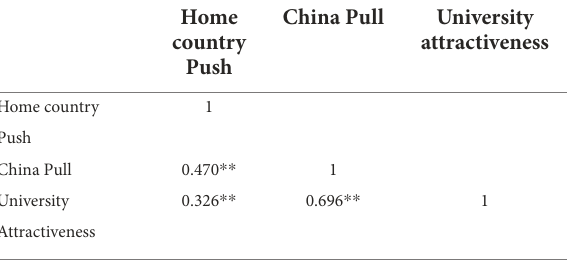
TABLE 4 Correlation analysis of influencing factors of international